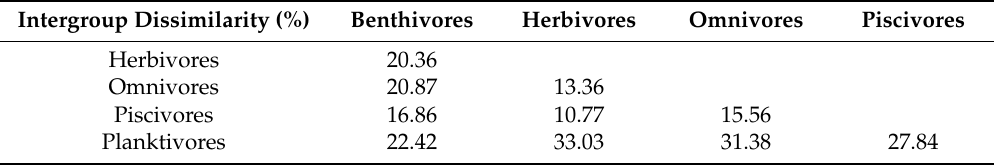
Table 3. Intergroup dissimilarity for each trophic group in the downstream (backwater zone) of the Daning